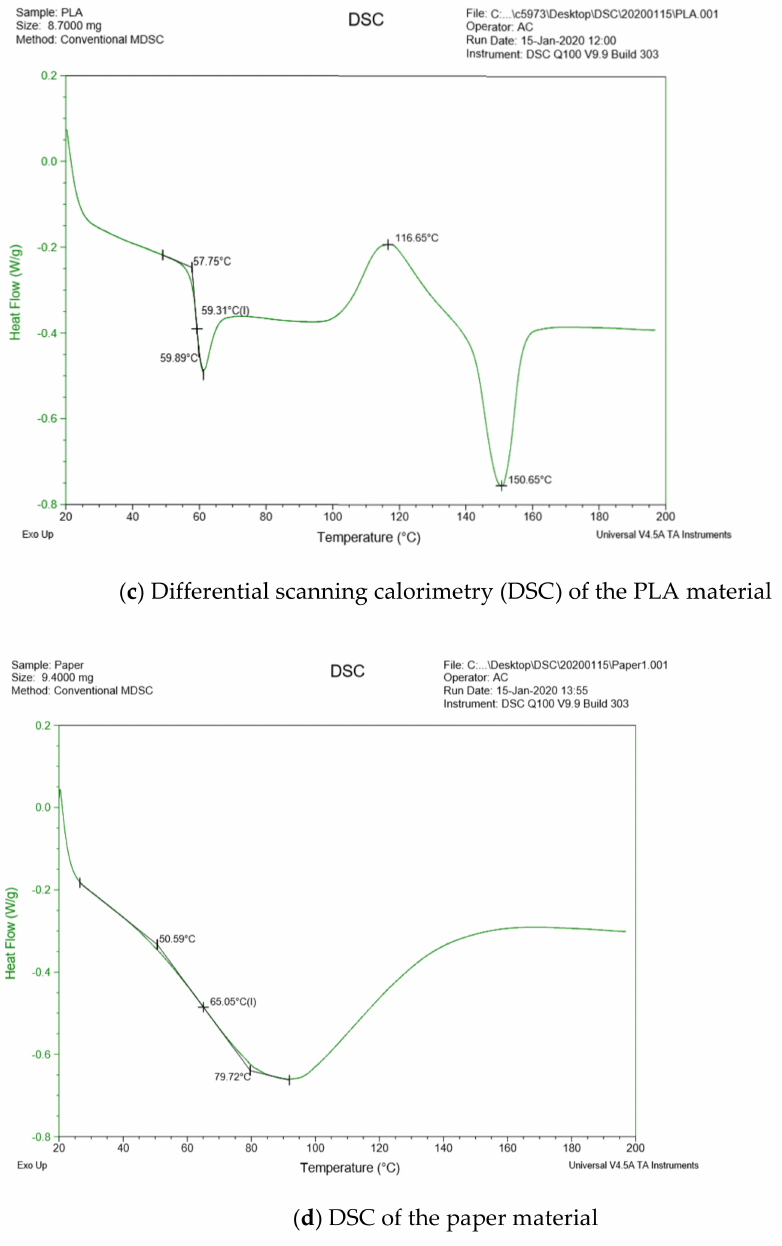
Figure 1. Thermogravimetric analysis (TGA) and differential scanning calorimetric (DSC) analysis of polylatic acid (PLA) and paper. Table 1. Mechanical and thermal properties of polylactic acid (PLA) and